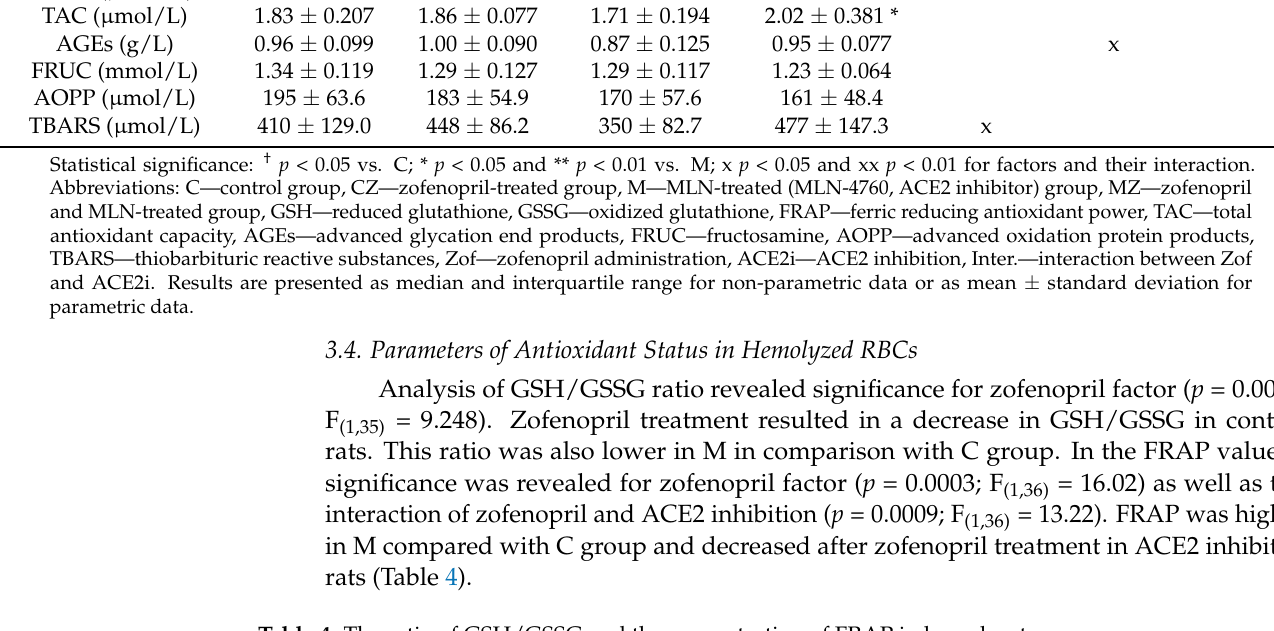
Table 4. The ratio of GSH/GSSG and the concentration of FRAP in